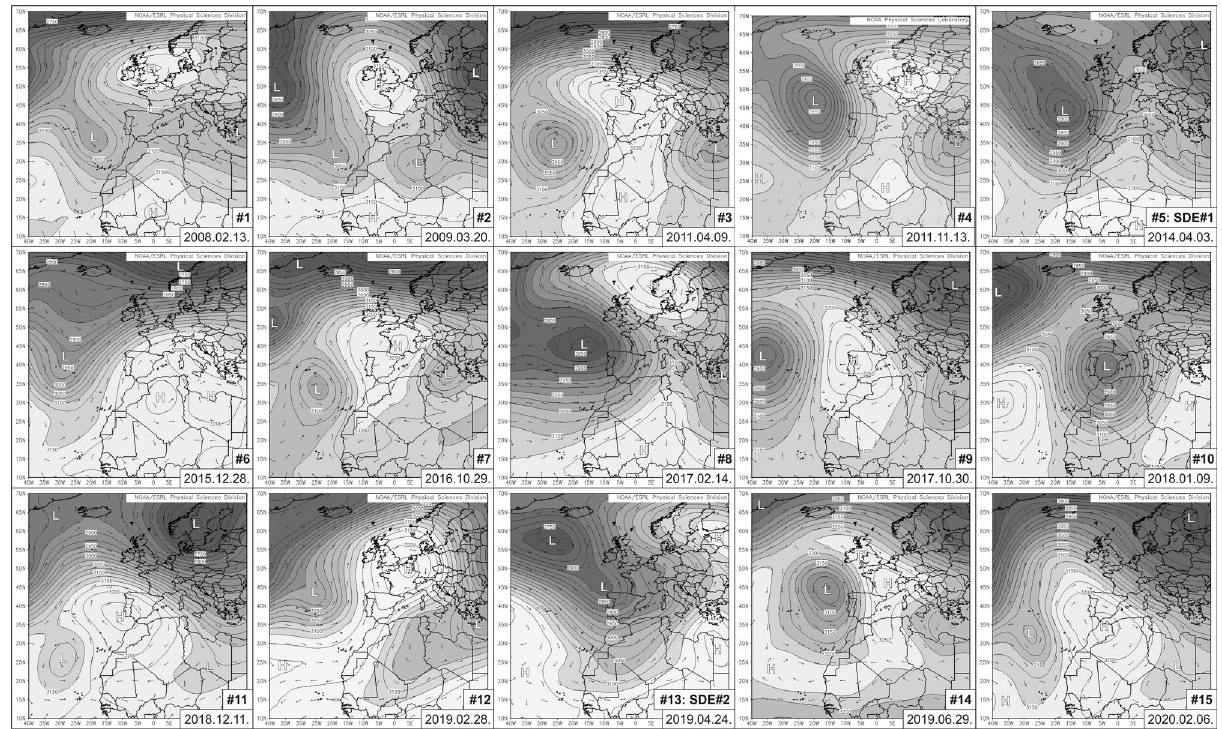
Figure 2. Synoptic meteorological situation of the identified Saharan dust events towards Iceland (geopotential height and wind vectors at 700 hPa).